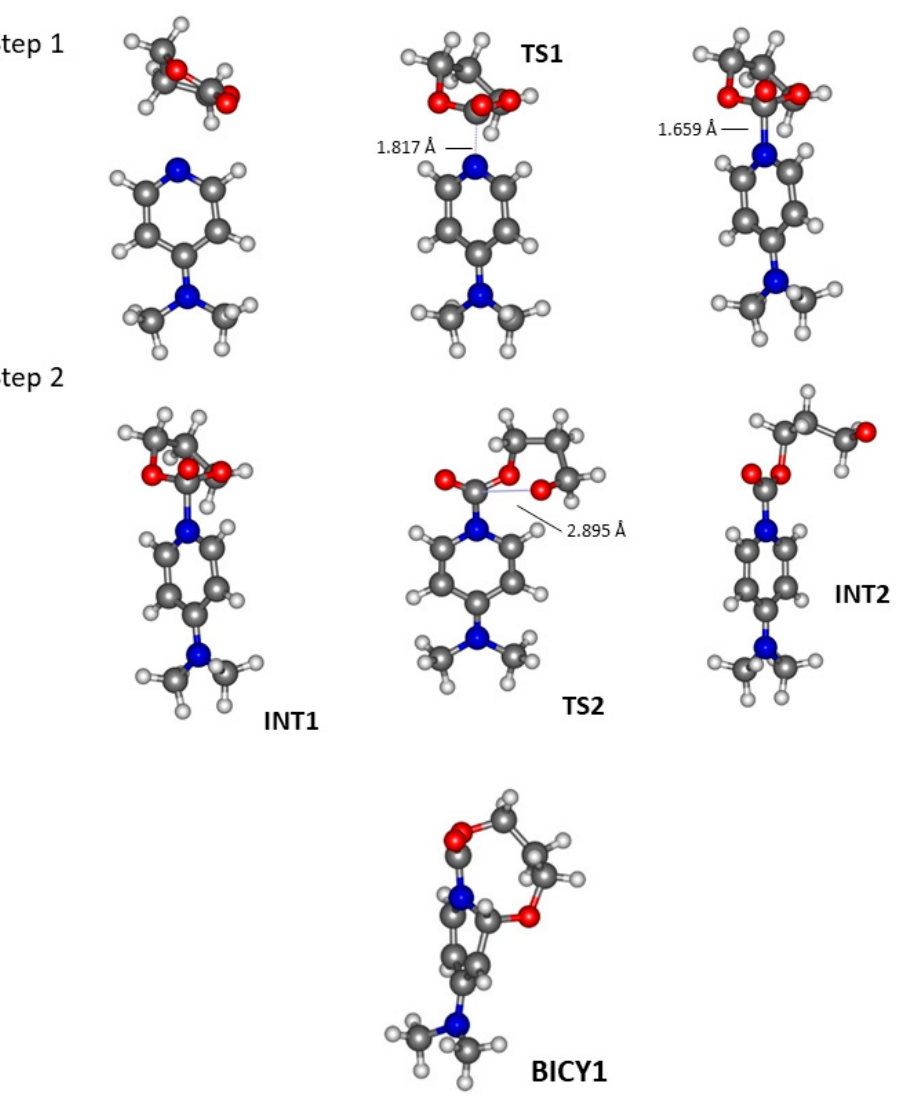
Figure 5. Optimized geometry structures of the species involved in the first and second steps for the nucleophilic mechanism of the DMAP-catalysed ring-opening polymerization of TMC. The structure of a possible bicyclo intermediate species ( BICY1 ) is also displayed (bottom). Colour code: C grey, O red, N blue and H white. Table 1. Experimental results. Reactions conducted for 1 h at room temperature in 2 mL CH 2 Cl 2